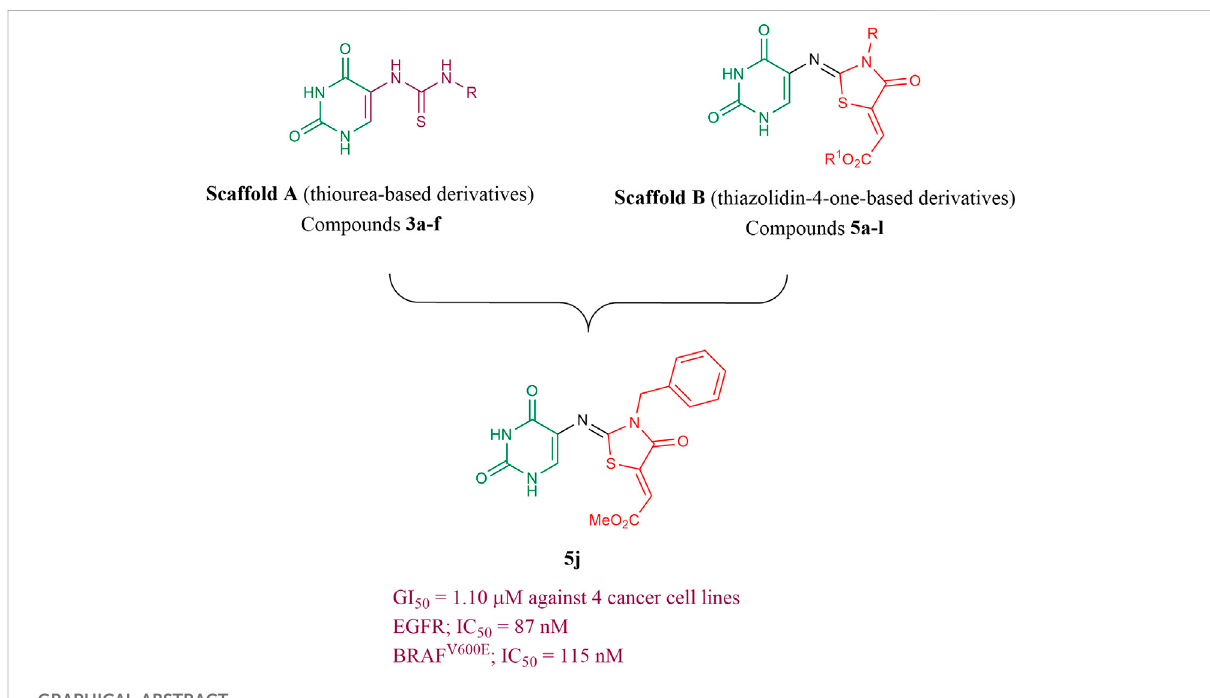
(Figure 2): the dihydropyrimidine-2,4-dione/thioureas 3a-f ( Scaffold A ) and the